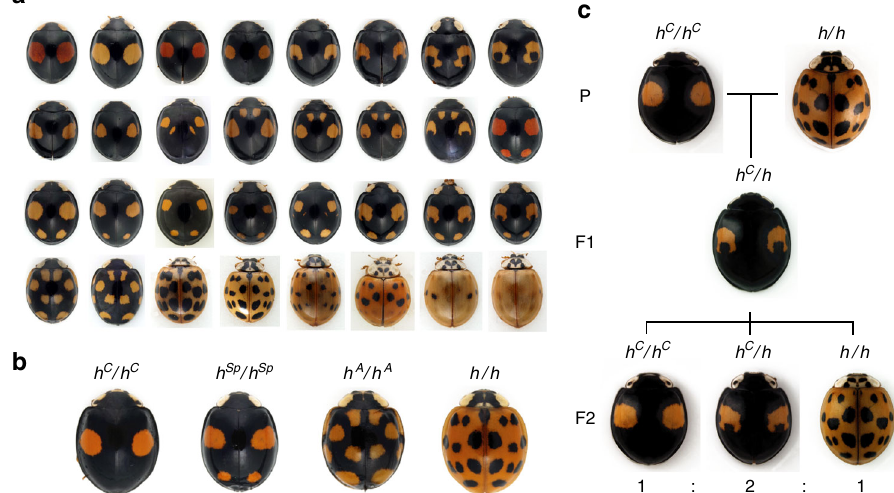
Fig. 1 Intraspeci fi c genetic polymorphisms of elytral colour patterns in H. axyridis . a Highly diverse elytral colour patterns of H. ayridis . b Four major alleles of the elytral colour patterns. h C , conspicua ; h Sp , spectabilis ; h A , axyridis ; h, succinea . c An example of inheritance of elytral colour forms. When h C / h C and h / h are crossed (P), all F1 progenies show the colour pattern of h C / h . Note the small black spots within the red spots in the F1 progeny. When the F1 heterozygotes are sibcrossed, F2 progeny shows three phenotypes ( h C / h C , h C / h and h / h ) at the 1:2:1 ratio predicted for Mendelian segregation of a single locus. Inheritance of any combination of colour patterns follows this segregation pattern. Images in Fig. 1a are used under license from Insect DNA